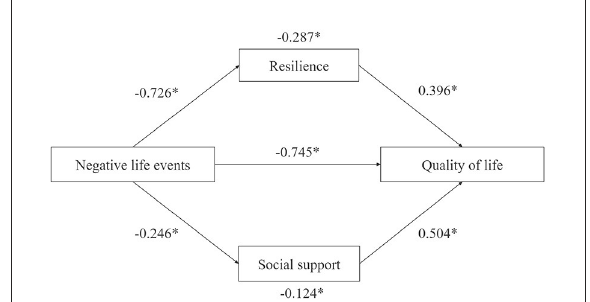
FIGURE2 Mediation model. * P <